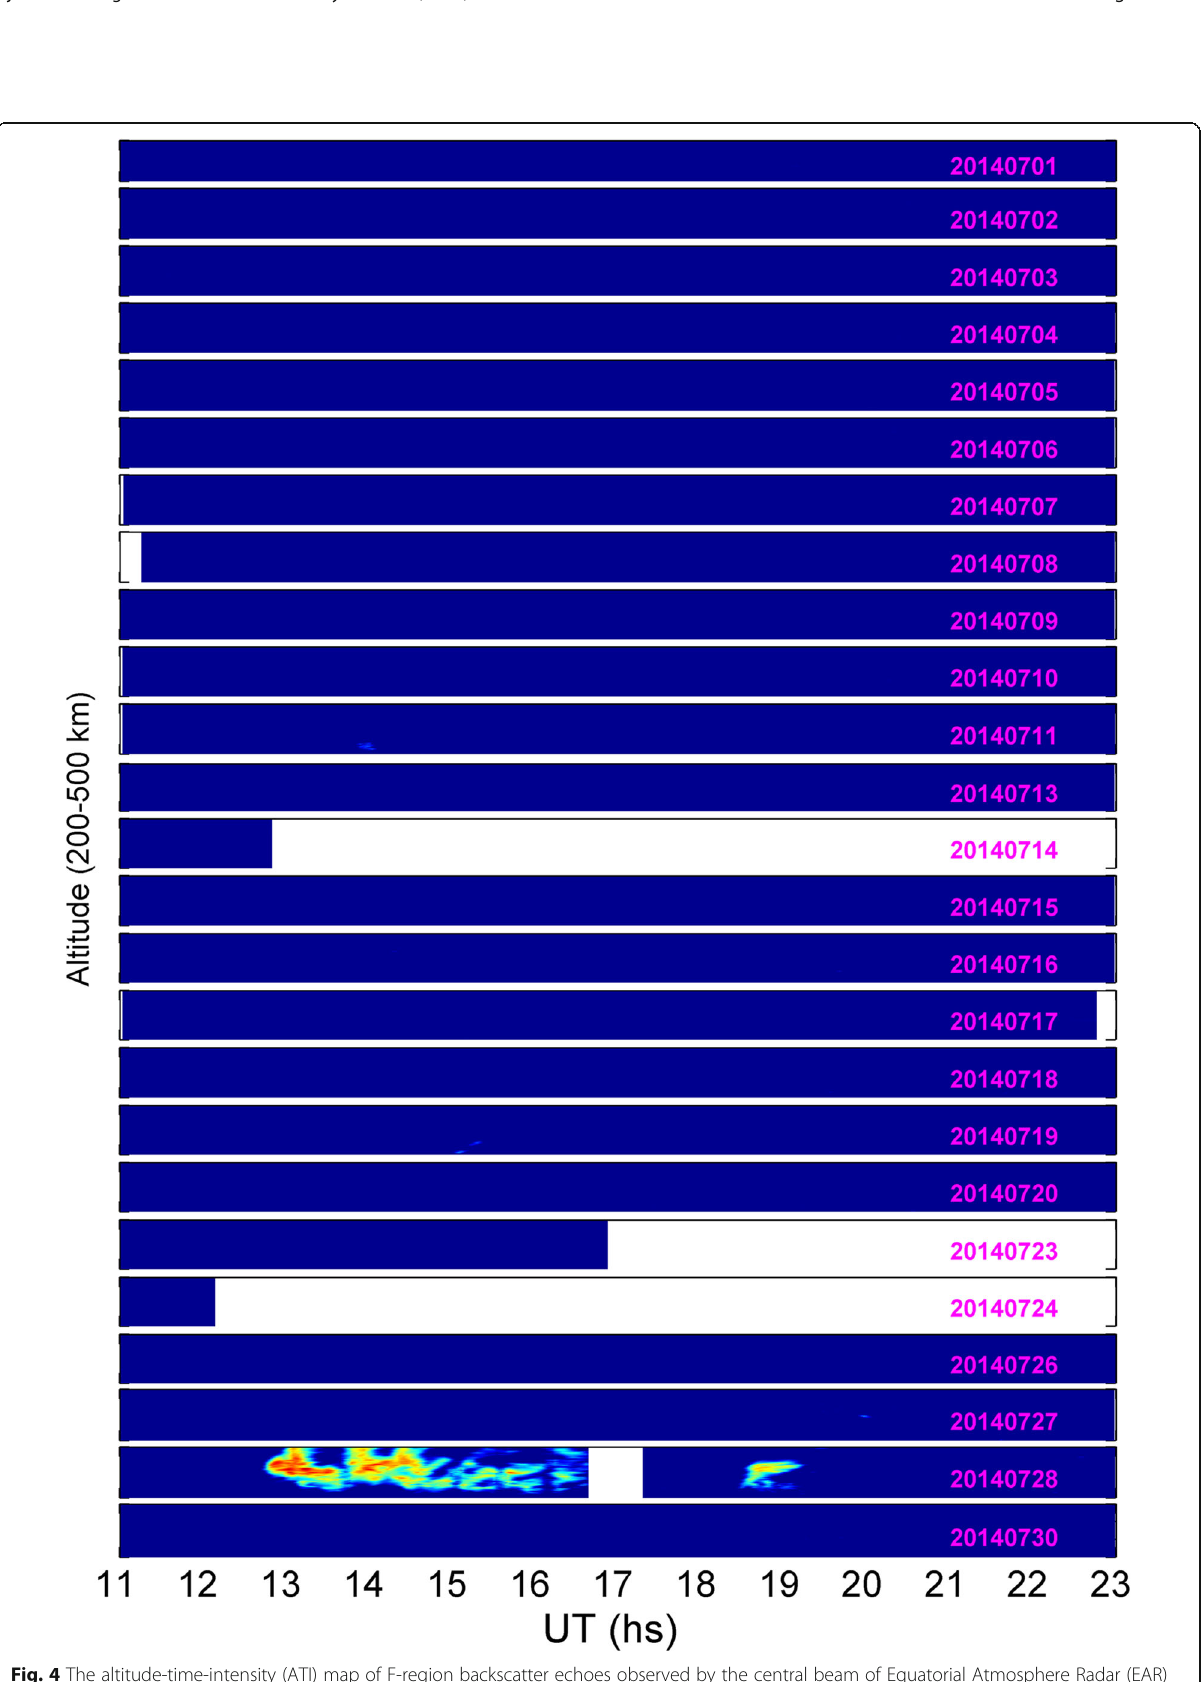
Fig. 4 The altitude-time-intensity (ATI) map of F-region backscatter echoes observed by the central beam of Equatorial Atmosphere Radar (EAR) for all days in July